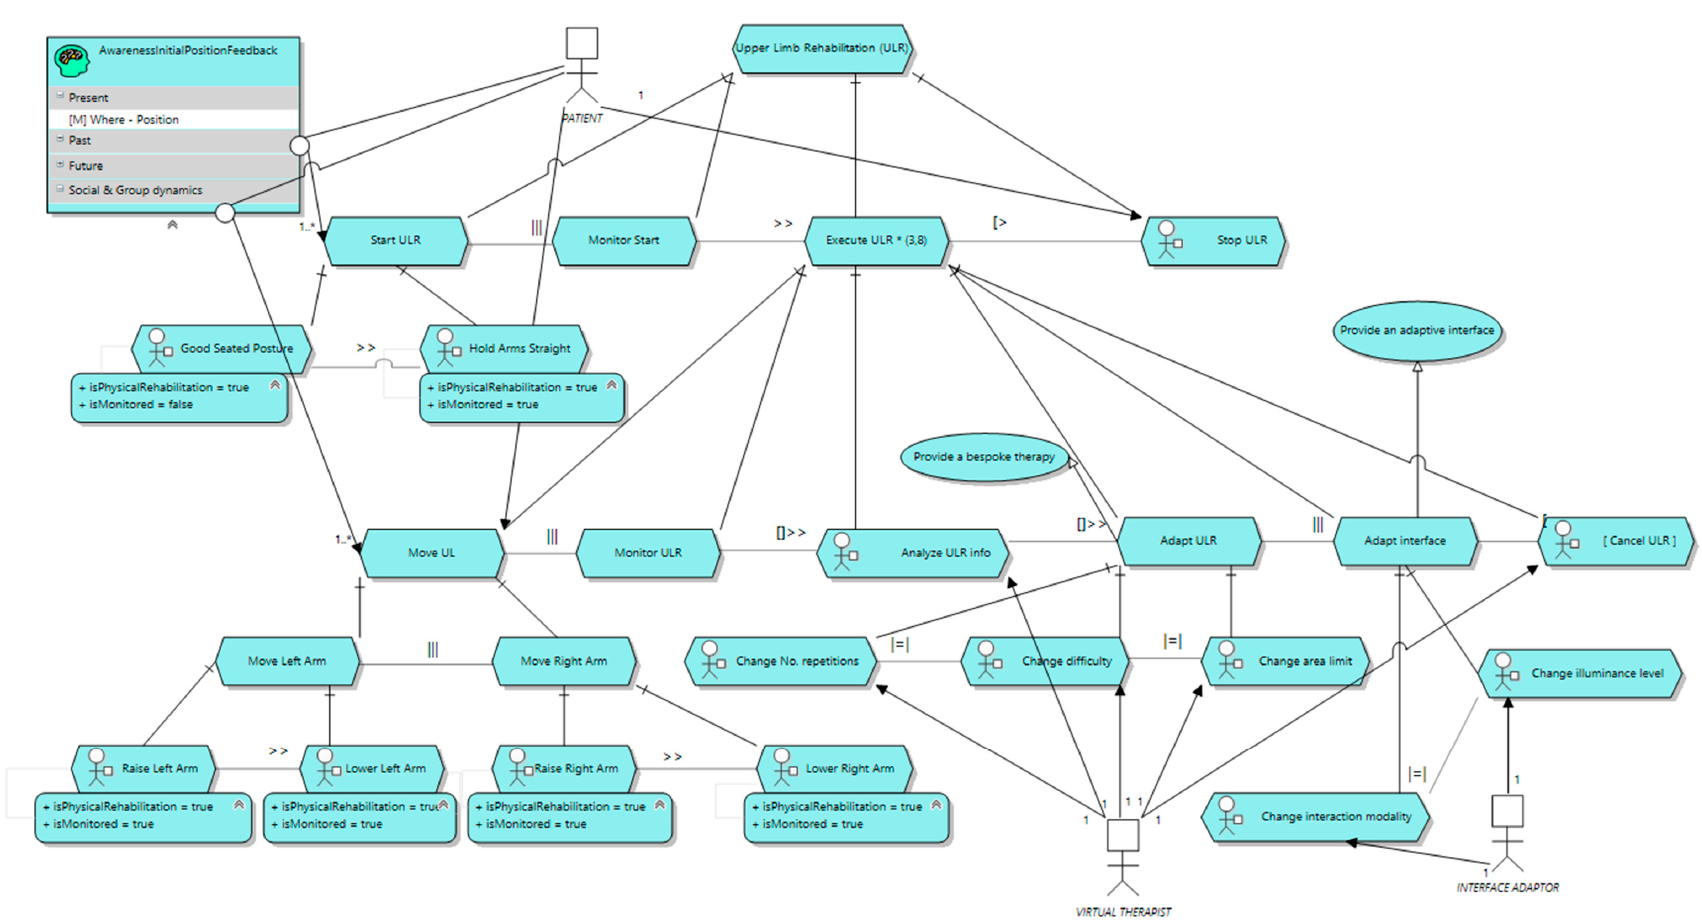
Figure 7. The upper limb rehabilitation core task model.